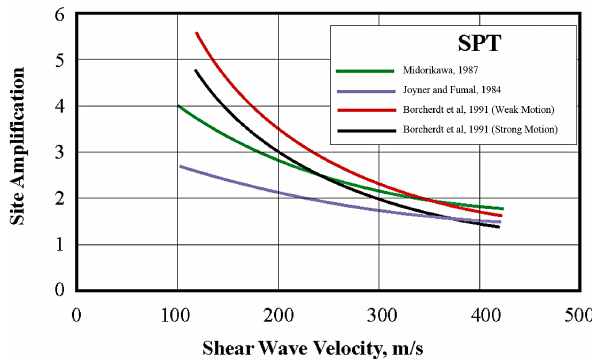
Figure 6. Site amplification calculation based on shear wave veloc- ity (Beliceli, 2006).